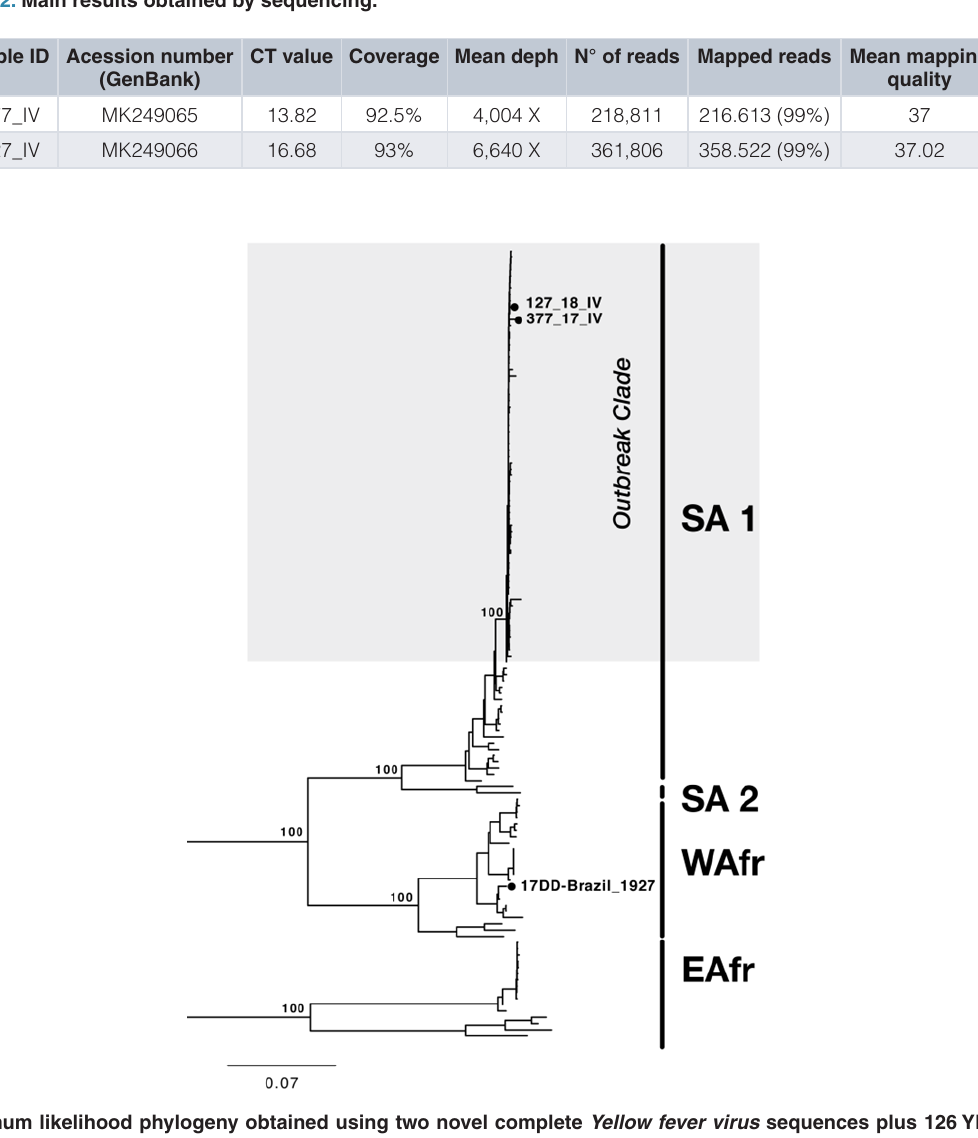
Table 2. Main results obtained by sequencing.